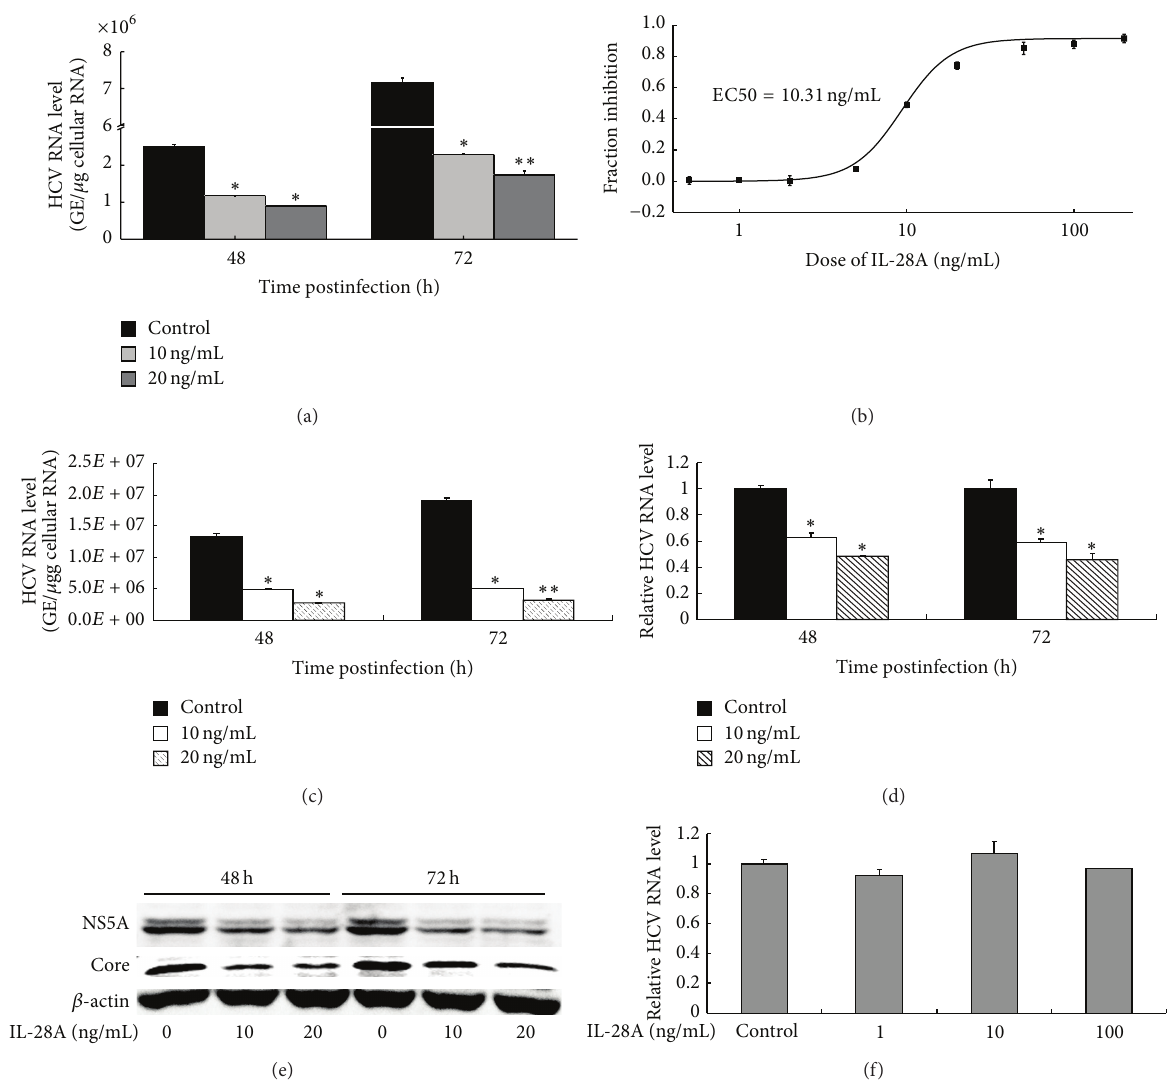
Figure 1: IL-28A suppresses HCV replication. Huh7.5 (a) and HLCZ01 (c) cells were infected with HCV (MOI = 0.1) for 6 h at 37 ∘ C. The medium was then removed and cells were incubated with IL-28A for 48 or 72 h at 37 ∘ C. (b) HCV-infected Huh7.5 cells were incubated with different doses of IL-28A for 72 h. (d) FL cells were incubated with IL-28A for 48 or 72 h. ((a), (b), (c), and (d)) Intracellular viral RNA was detected by real-time PCR. The results are the average of three independent experiments performed in triplicate. (e) Huh7.5 cells were treated as described in part (a). NS5A and core proteins were detected with western blot. (f) Huh7.5 cells were pretreated with or without IL-28A for 12h. The medium was then removed, and cells were inoculated with HCV (MOI = 0.1) for 6h at 37 ∘ C. Intracellular viral RNA was detected by real-time